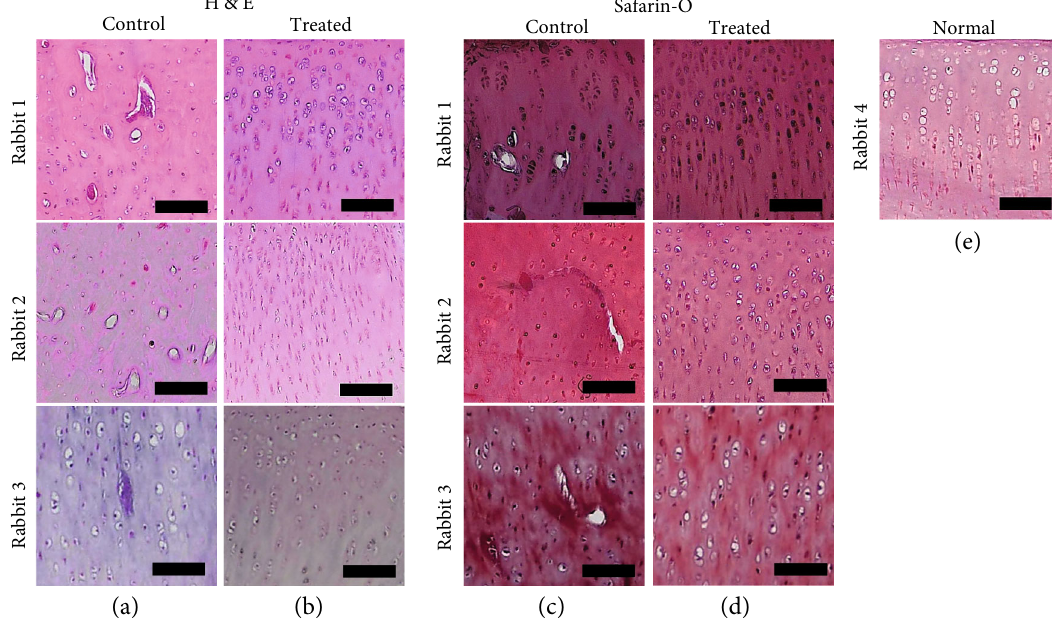
Figure 8: The histology of cartilages with or without iPSC – MSC-chondrocytes transplantation ( n = 3 ). (a, b) The H & E staining of histology of the cartilage of the osteoarthritis (OA) rabbit model without (a) and with cell transplantation (b). (c, d) Safranin O staining of cartilage without (c) or with (d) cells transplantation. (e) Normal rabbit cartilage with Safranin O staining. After iPSC – MSC-chondrocytes transplantation, the morphology and sulfated glycosaminoglycan expressions of transplanted cartilages were more similar to normal cartilage than control cartilage. Scale bar = 100 μ m